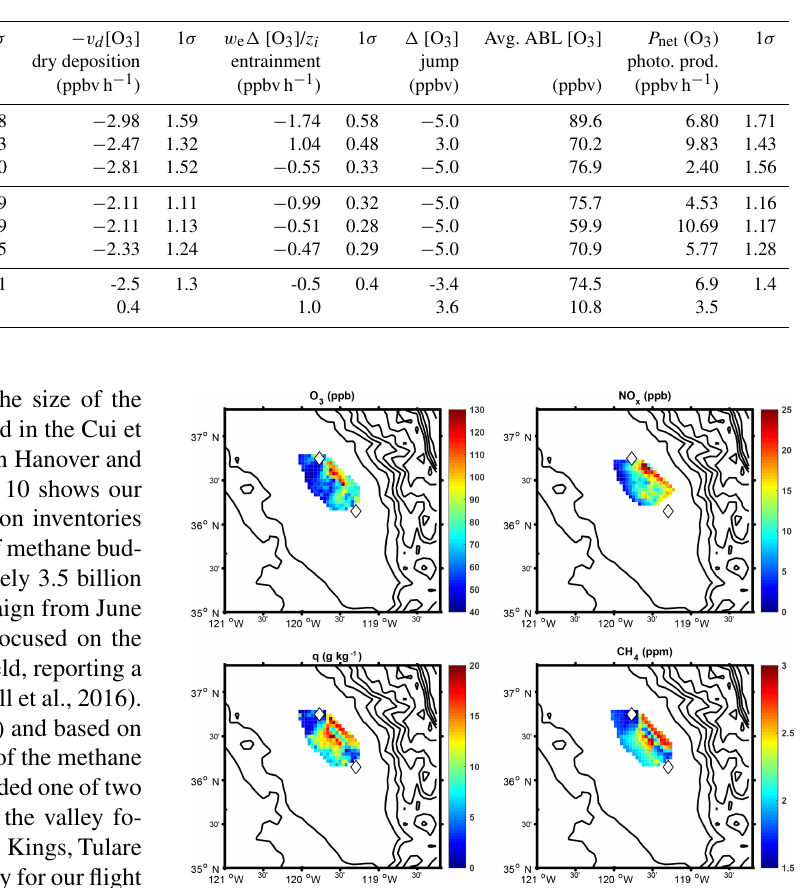
Table 2. O 3 budgets for the six EPA flights. All averages are calculated using ABL data only. The columns labeled 1 σ represent the estimated error in the preceding term with the same units.